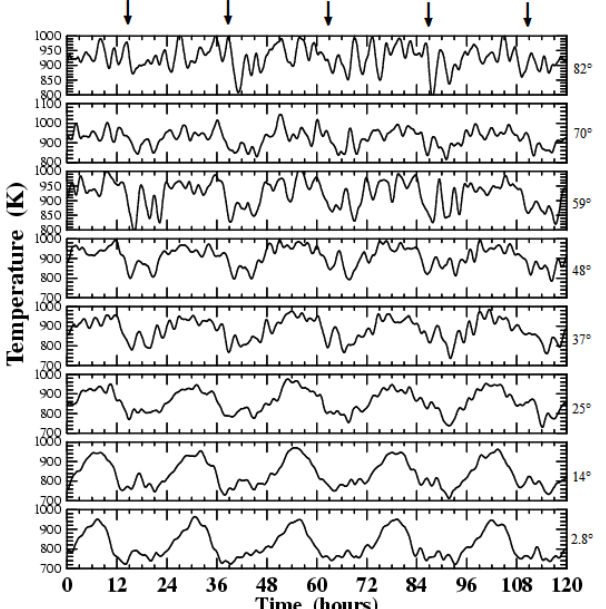
Fig. 7. Same as Fig. 6 except for the Southern (summer) Hemi- sphere.